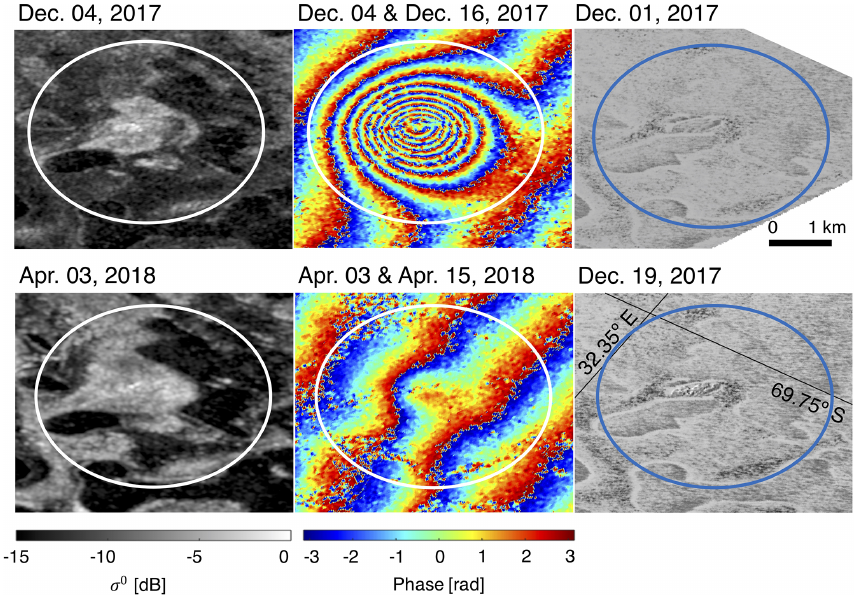
Figure 9. Sigma nought ( σ 0 ) and interferograms for a lake feature in the east of the RBIS experiencing drainage in December 2017 (upper panels) and ice-cover collapse in April 2018 (lower panels). Two near-contemporaneous Landsat 8 panchromatic (band 8) images are also shown (right panels). The Landsat images are acquired from Google Earth Engine (Gorelick et al.,